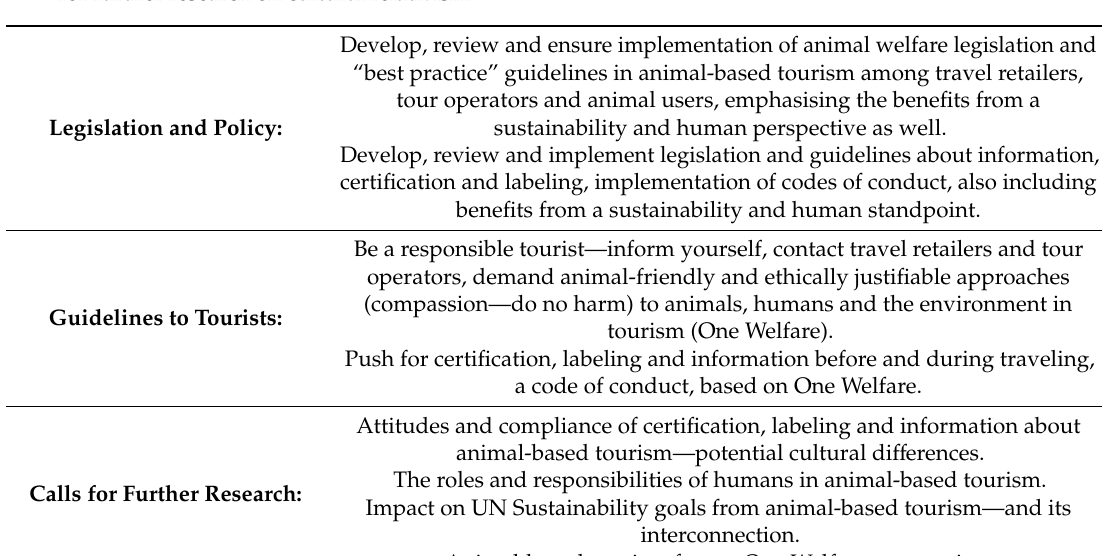
Table 2. Summary of workshop conclusions on legislation and policy, guidelines to tourists and calls for further research on cultural